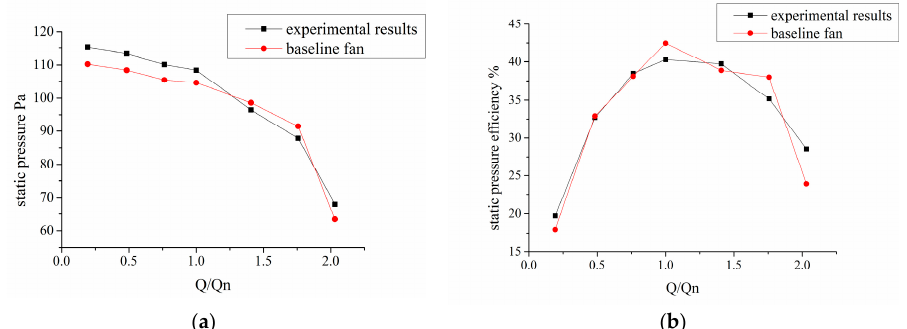
Figure 6. Comparison of characteristic quantities for steady flow simulation: ( a ) static pressure–flow rate curve; ( b ) static pressure efficiency–flow rate curve.